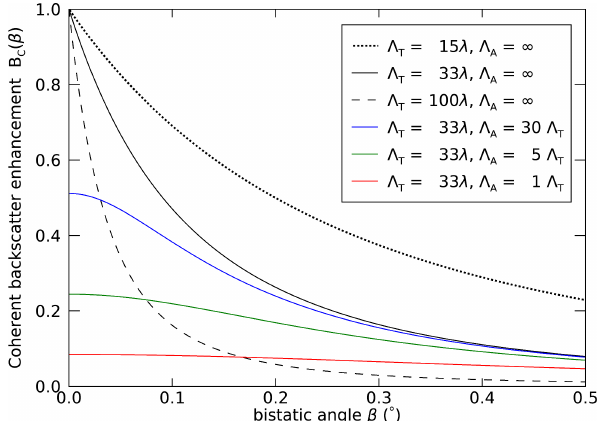
Figure 6. Modeled peak shape of the CBOE for different scattering mean free paths (cid:51) T given in multiples of the wavelength λ and for different absorption mean free paths (cid:51) A (in multiples of (cid:51) T ) in a medium with small scattering particles (porosity coefficient K = 1). For a non-absorbing medium ( (cid:51) A = ∞ ) a very sharp peak can be observed. Already with a weak absorption (cid:51) A = 30 (cid:51) T (blue) the peak height is reduced to 50% and the peak becomes much rounder. For comparable scattering and absorption lengths the peak is not noticeable